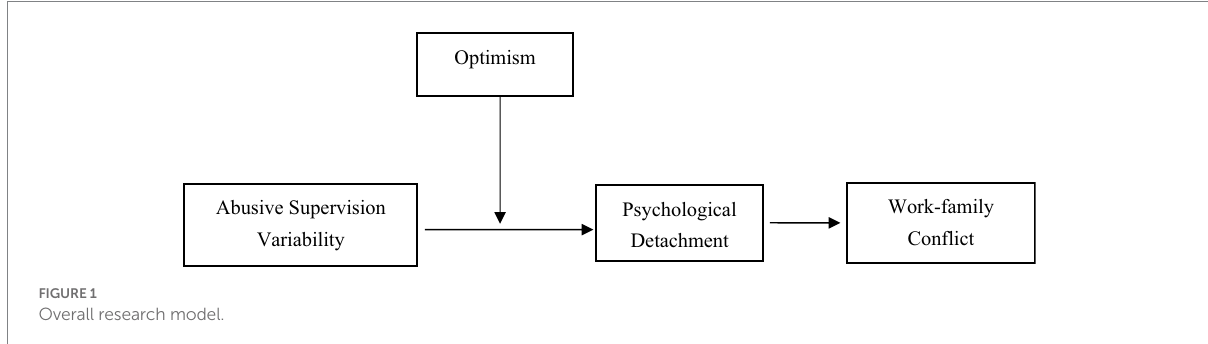
FIGURE 1 Overall research